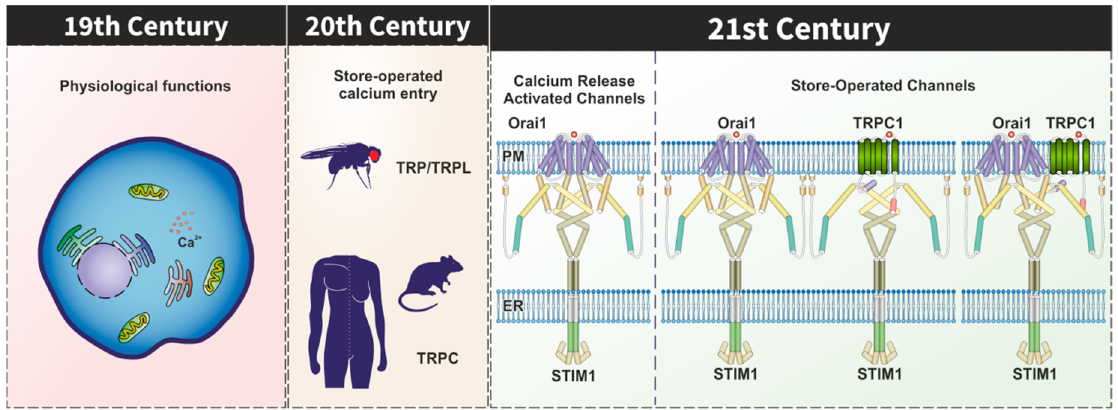
Figure 1. Milestones in the characterization of Ca 2+ entry. In the early 1880s, Ringer revealed the functional role of Ca 2+ entry in heart contraction. About a century later, store-operated Ca 2+ entry (SOCE) was discovered and, by that time, transient receptor potential (TRP) channels were identified, first in Drosophila and then in mammals. In 2005 and 2006 STIM1 and Orai1, the key components of the Ca 2+ release-activated Ca 2+ (CRAC) channels, were identified, and canonical TRP (TRPC) channels were found to participate in a non-selective store-operated current together with STIM1 and Orai1. The model represents two alternatives for the involvement of TRPC in the store-operated channels.